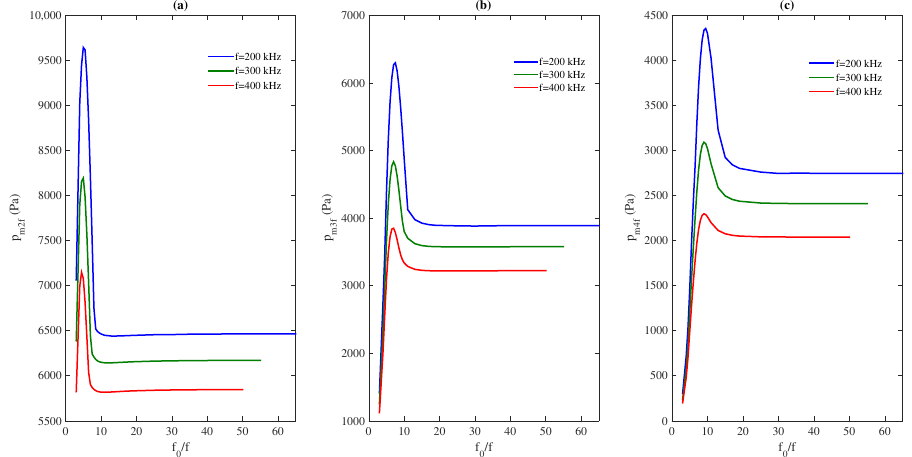
Figure 8. Maximum amplitude of 2 f ( a ), 3 f ( b ), and 4 f ( c ) in the cavity of length L = 16 λ vs. f 0 / f , for three different source frequencies f = 200 kHz (blue line), f = 300 kHz (green line), and f = 400 kHz (red